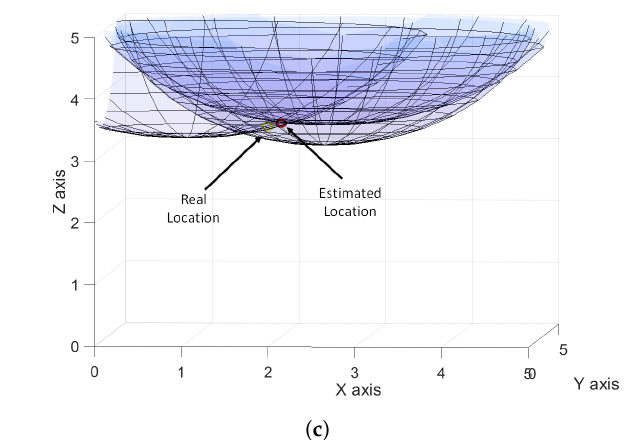
Figure 5. Intersections between the three spheres for the ( a ) first scenario, ( b ) second scenario, and ( c ) third scenario.